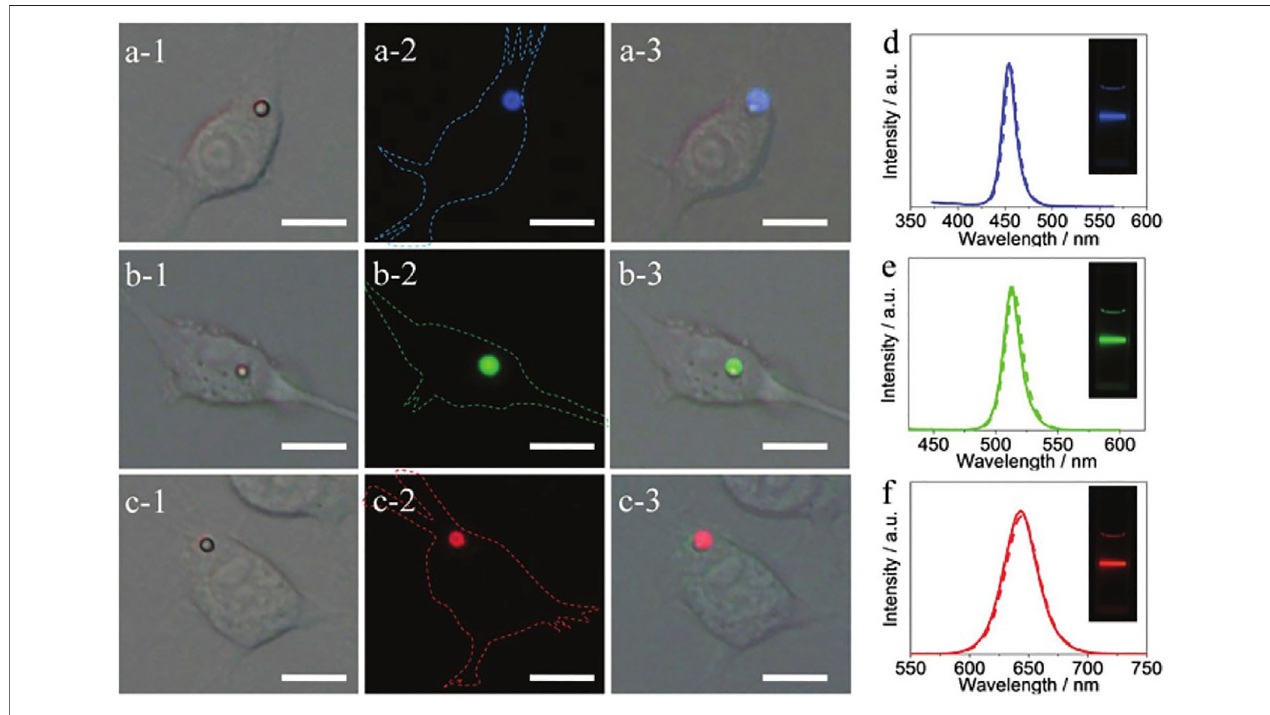
FIGURE 10 | (A,B,C-1) and (A,B,C-2) are bright- fi eld and fl uorescence images of RAW 264.7 cells incubated with CsPbX 3 NCs@MHSs. (A,B,C-3) are superimposed pictures of (-1) (-2). (D – F) show the fl uorescence spectra of CsPbX 3 NCs@MHSs (dotted line) and the corresponding NCs colloidal solution (solid